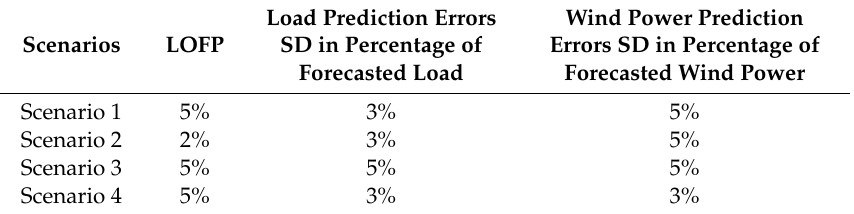
Table 2. Parameters of each